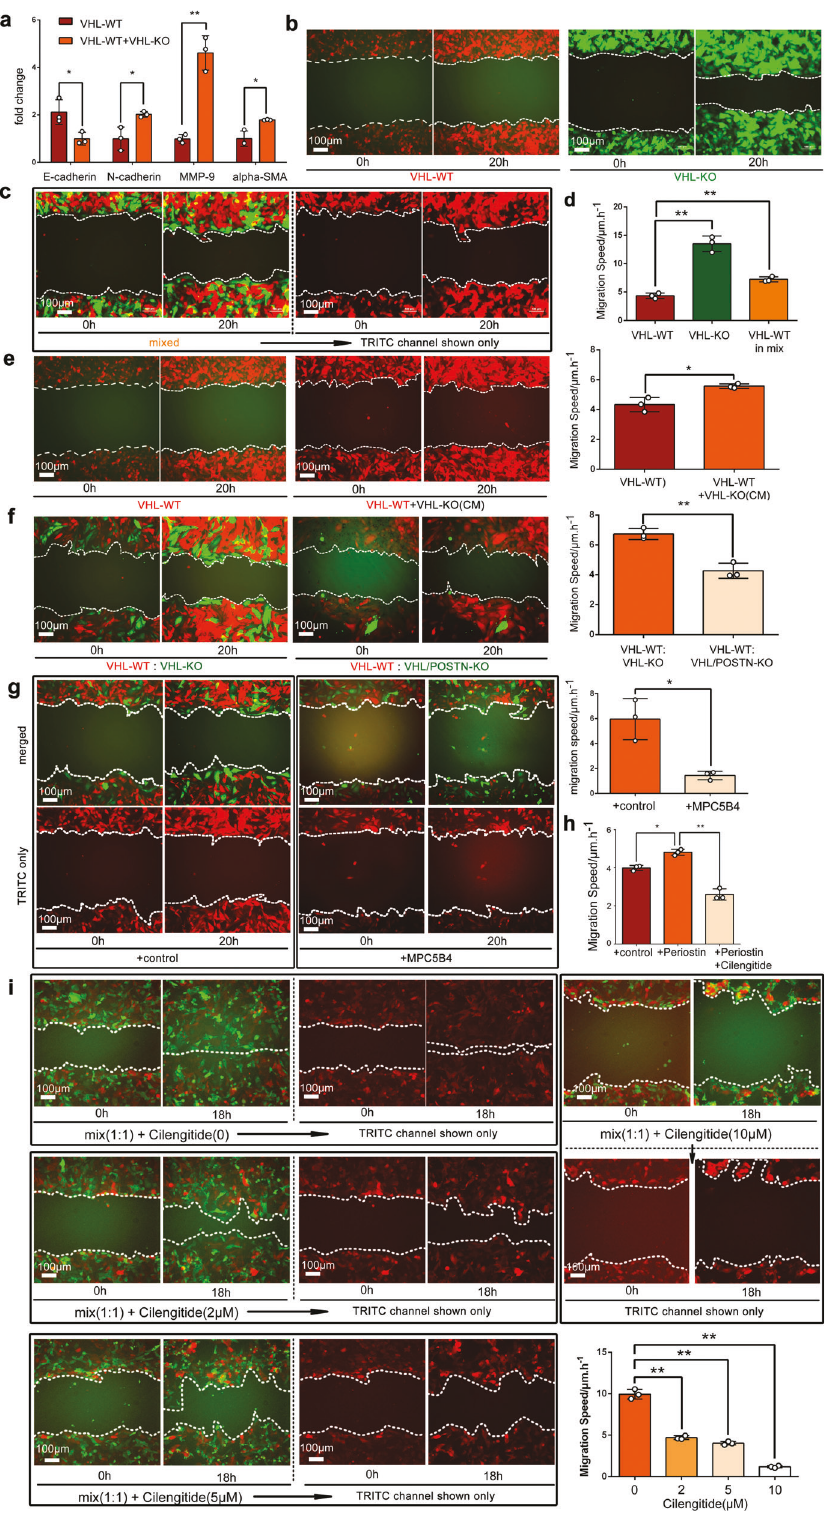
Supplementary Movie S6a, b). The addition of recombinant POSTN to VHL-WT cells signi fi cantly promoted their motility, which was blocked by the cyclic-peptide integrin inhibitor, cilengitide (Supplementary Fig. 4i and Fig. 5h). The addition of recombinant POSTN to VHL-WT cells activated focal adhesion kinase (FAK) via